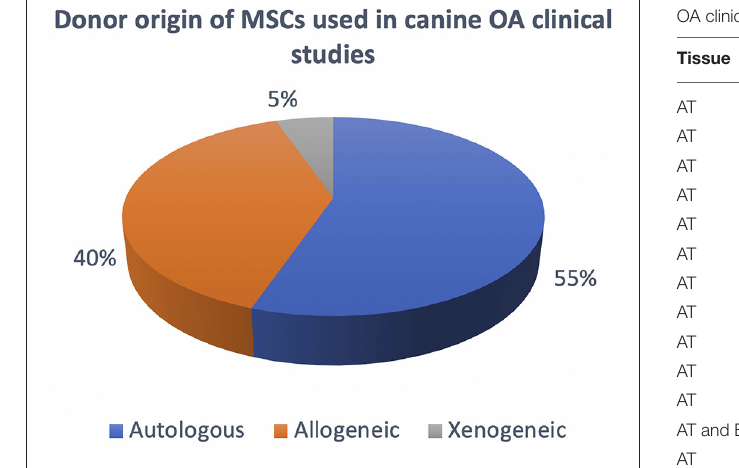
FIGURE 3 | Overview of the current use of autologous, allogeneic and xenogeneic cells in canine OA clinical studies.